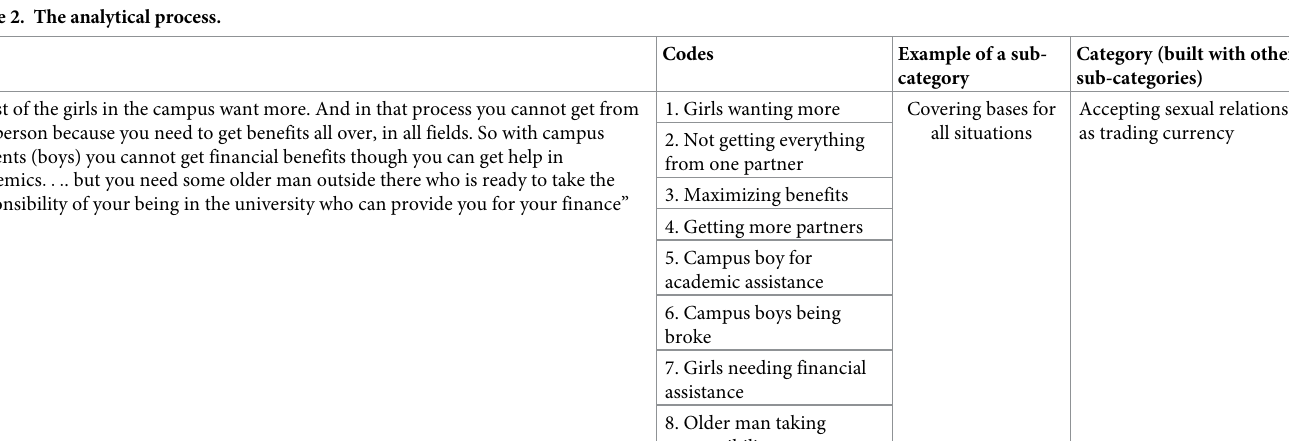
Table 2. The analytical process.